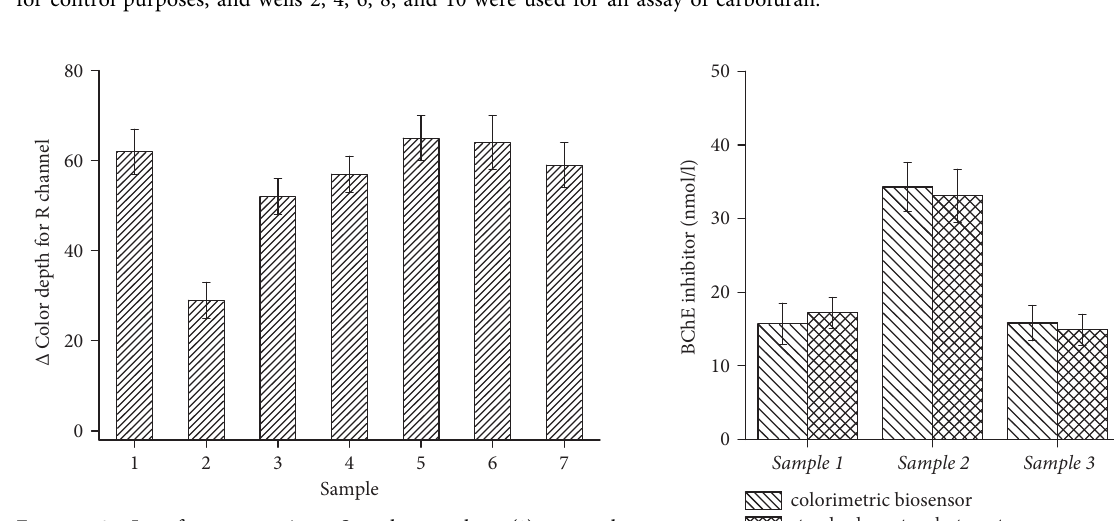
Figure 8: Interference testing. Sample number (1) control (deionized water), (2) ethanol 96% v/v, (3) ethanol 50% v/v, (4) ethanol 10% v/v, (5) sunflower oil, (6) phosphate-buffered saline pH 7.4, and (7) herbicide Roundup. Standard error of the mean is depicted for five independent repeats ( n � 5).